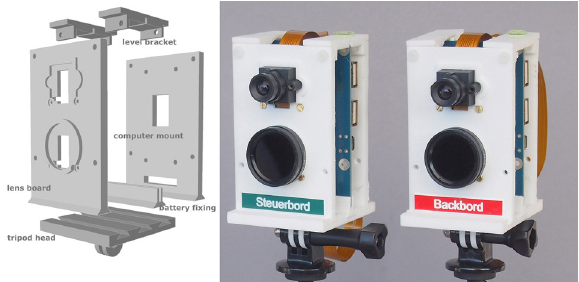
Figure 7: Camera housing design fabricated by a 3D